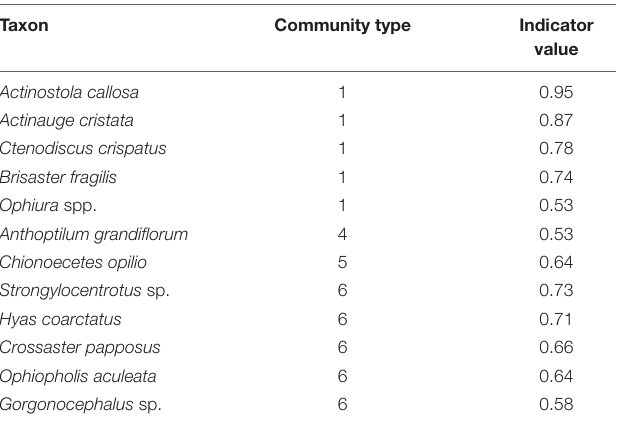
TABLE 3 | Indicative values of taxa with indicator values > 0.5, for each